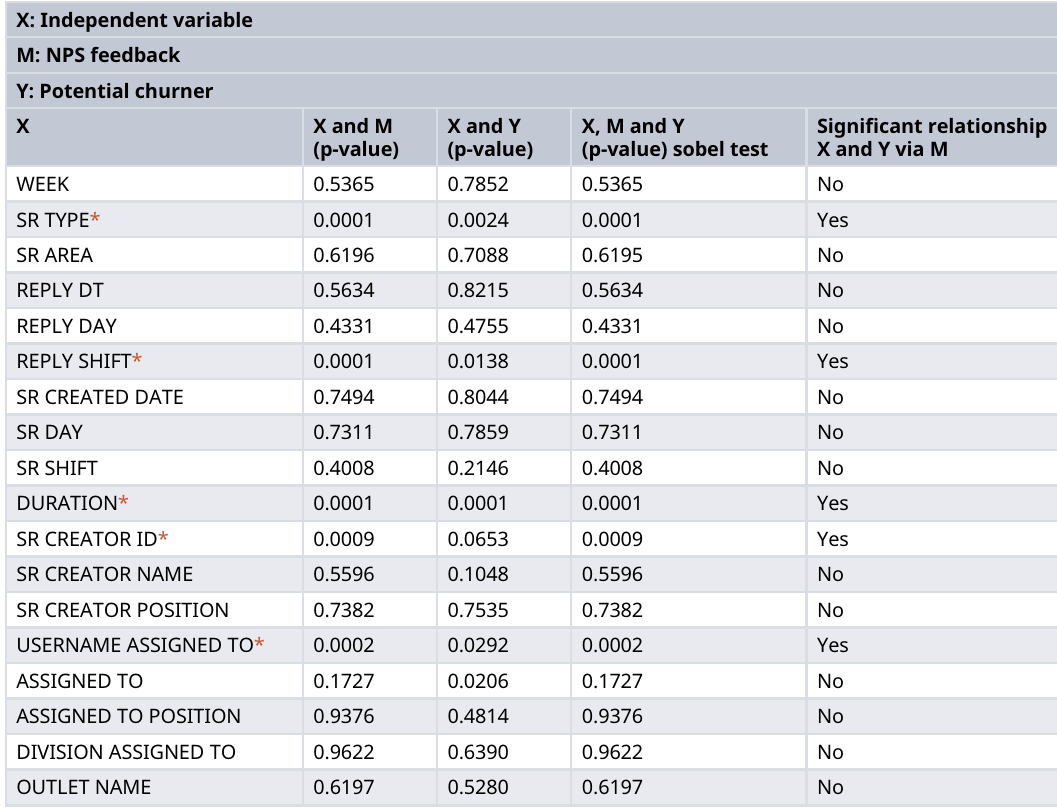
Table 14. Mediation analysis